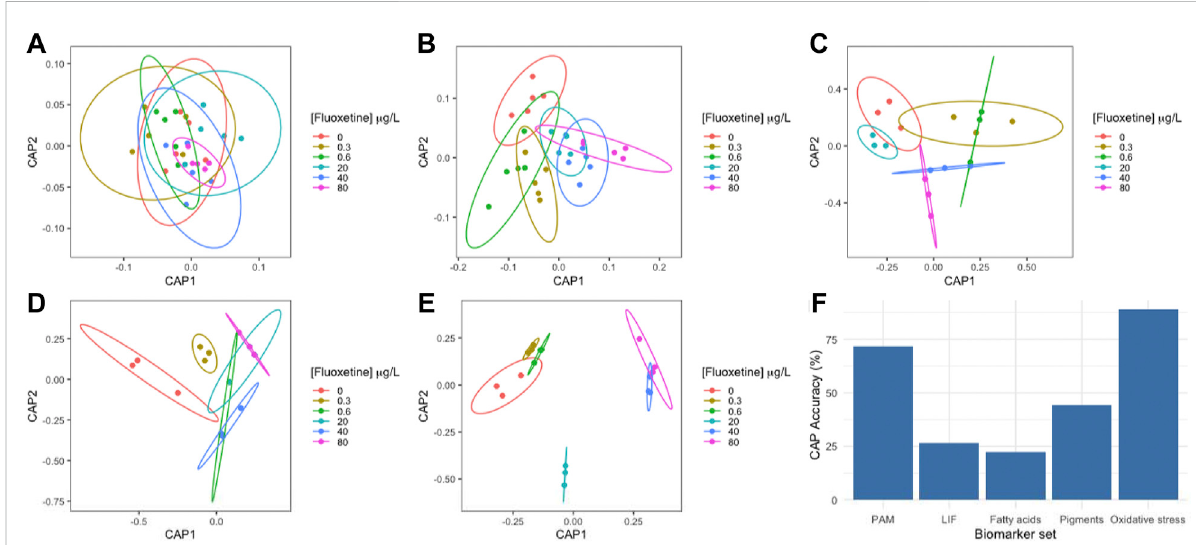
FIGURE 7 Ulva lactuca Canonical Analysis of Principal components (CAP) following a 48-h exposure to different fl uoxetine concentrations. (A) PAM- derivedvariables. (B) LIF-derivedvariables. (C) Fattyacidpro fi le. (D) Pigmentpro fi le. (E) Oxidativestressbiomarkers. (F) CAPaccuracy. N =5(PAMand LIF); N = 3 (Fatty acids, pigments, and oxidative